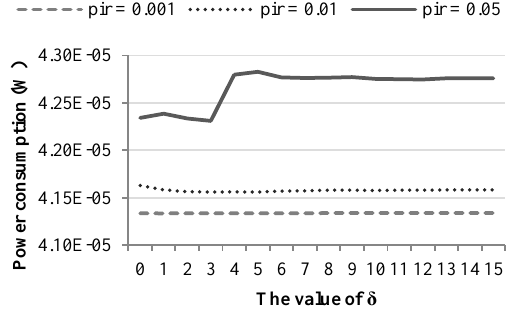
Figure 8. Effect of δ on power consumption for different values of pir.